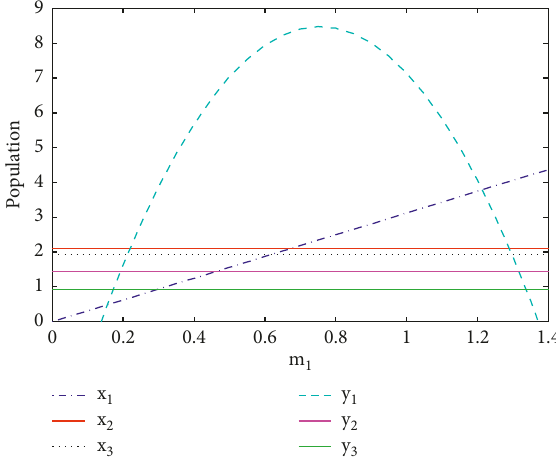
Figure 7: Effect of m